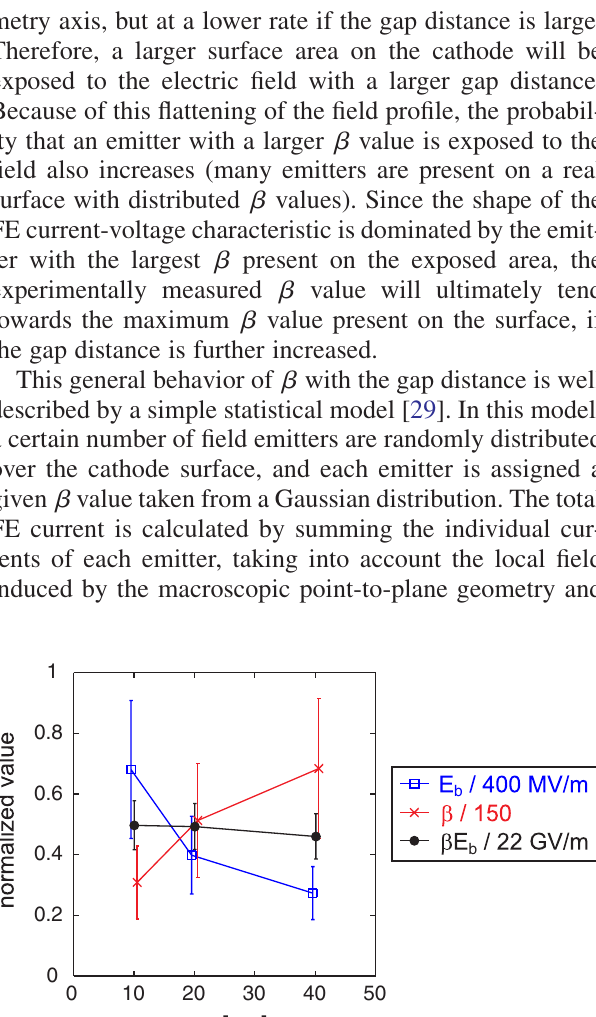
FIG. 6. Profiles of the electric field on the cathode surface, calculated for different gap distances. The anode is a hemispheri- cal rounded tip, 2.3 mm in diameter, and the cathode is an infinite plane surface. The maximum value of the field corresponds to the parallel plate macroscopic field V=d , where V is the voltage across the electrodes and d the gap distance.